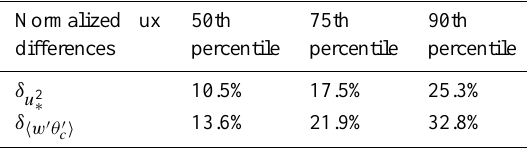
Table 1. Number of runs discarded by quality control and other criteria.